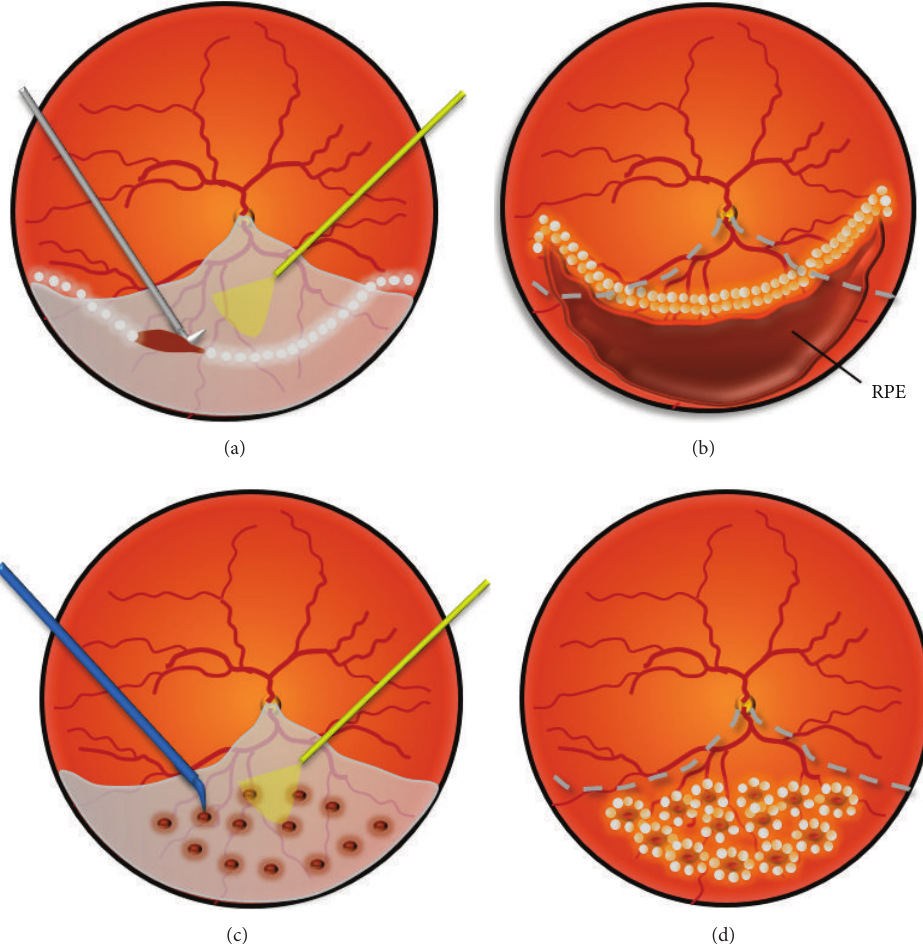
Figure 1: Schematic drawings of traditional relaxing retinectomy and radial retinotomies with endodiathermy. ((a), (b)) The relaxing retinectomy should extend into the normal retina on each end of the contractive area, resulting in a large area of defective retina and exposed RPE. (c) A series of retinotomies are created via endodiathermy in a radial pattern to relax the stiffened and foreshortened retina. All of the retinotomies are limited to the detached retina. (d) These individual round retinal incisions elongate in an oval fashion during the water-air exchange. In turn, this elongation enables the foreshortened retina to stretch and recover the